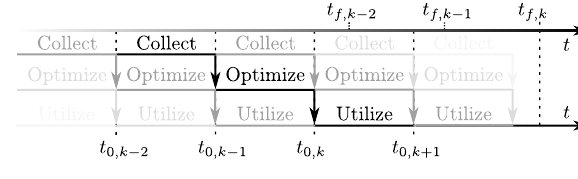
Figure 6: The monitoring system consists of a three- step procedure of collecting, optimizing, and